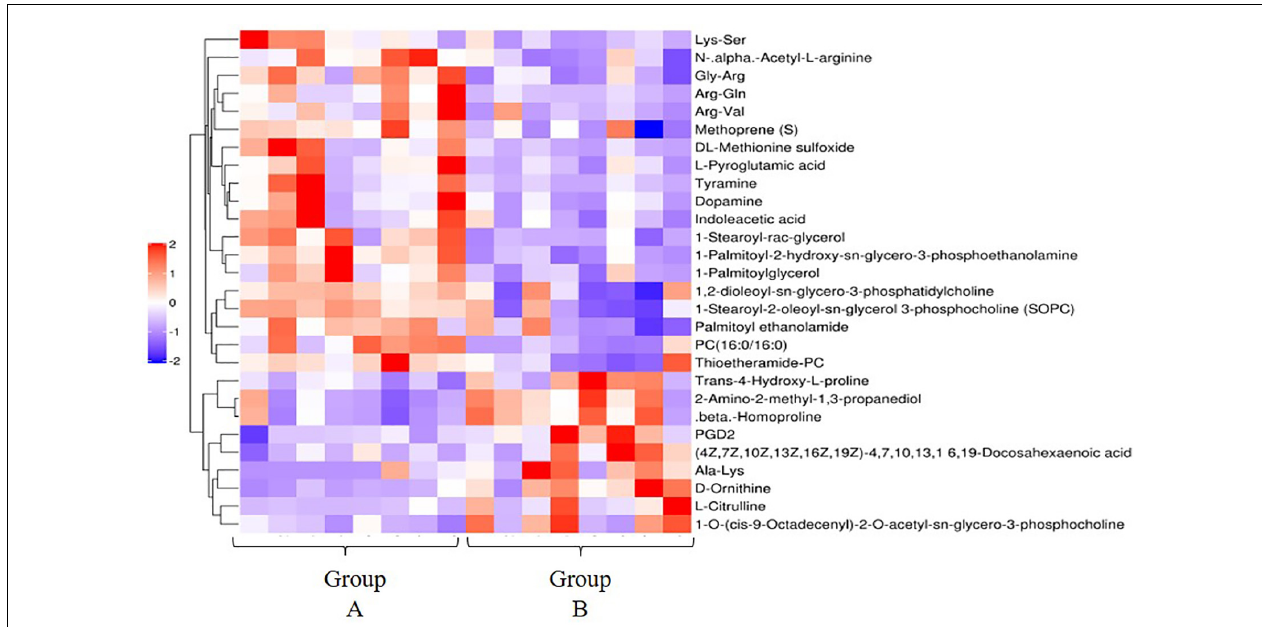
FIGURE 3 | Hierarchical clustering analysis of the differential metabolites in the high- and low-residual feed intake (RFI) groups in the positive ion mode. Red and blue respectively represent upregulated and downregulated differential metabolites (DEs).